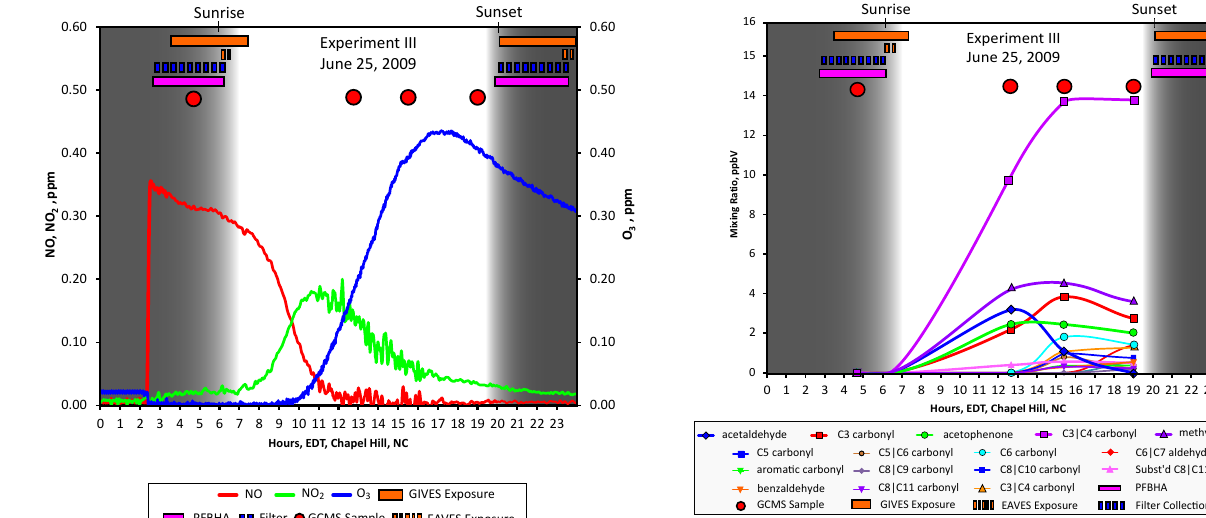
Fig. 2. Time series of ozone (O 3 ), nitric oxide (NO), and nitro- gen dioxide (NO 2 ) during experiment III (JN2509), performed with SynUrb54 and NO x injected in the dark at 02:30EDT. Color bars represent the type and time window for biological exposure sam- pling (GIVES, EAVES), for filter sampling, and for impinger sam- pling for PFBHA carbonyl analysis; red dots represent the time of VOC sampling for GCMS direct injection analyses.